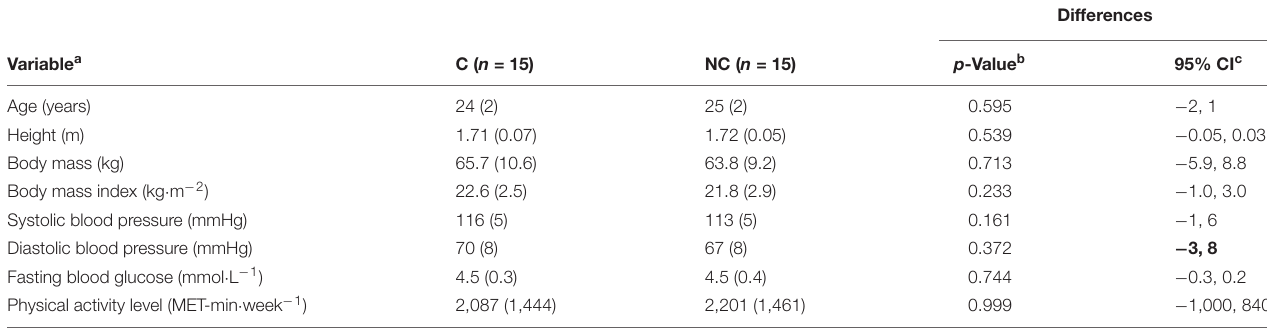
TABLE 1 | Participants’ baseline